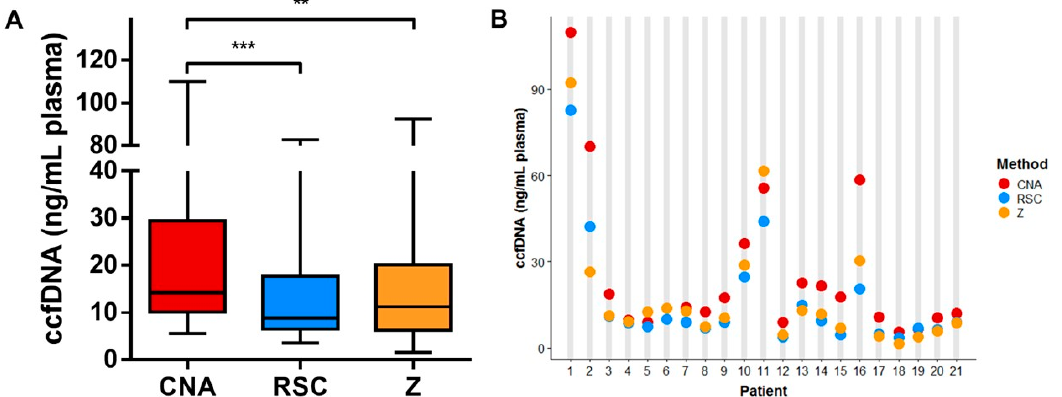
Figure 1. Comparison of the circulating cell-free DNA (ccfDNA) yield among different extraction methods. ( A ) Boxplot illustrating the yield as measured with Qubit per method. Horizontal lines represent the median, the boxes, and the interquartile range. ( B ) Individual patient ccfDNA yields for the different extraction methods are displayed for the plasma of twenty-one nonsmall cell lung carcinoma (NSCLC) patients. One-way ANOVA multiple comparison test, ** p < 0.01, *** p < 0.001.